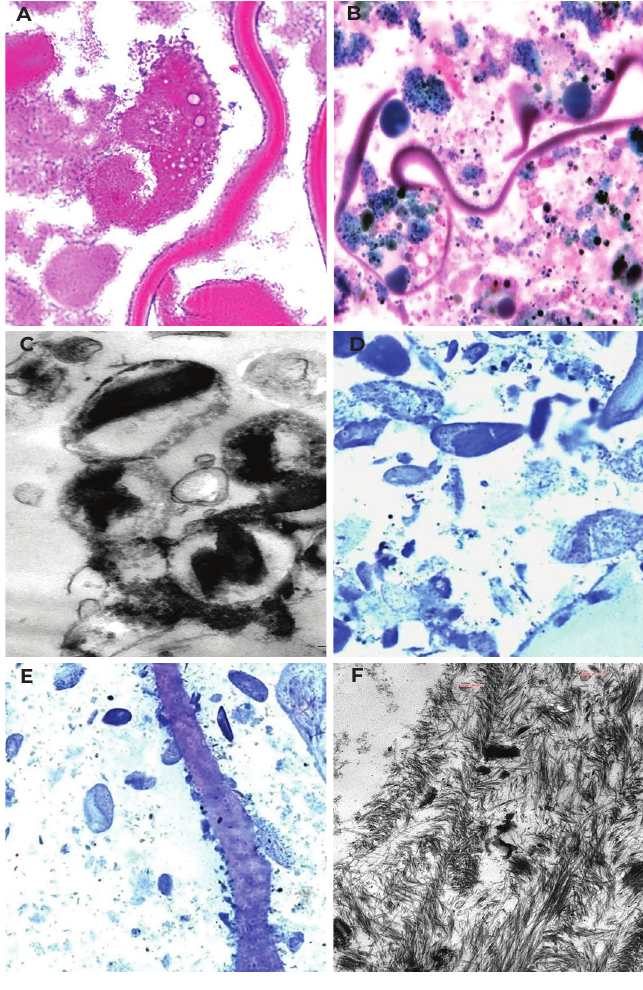
Figure 4 - Alveococcus of the liver 3 days after HIFU ablation. A - Destruction of protoscolex and laminae of alveococcal vesicles. Histological section x 400. B - Destruction of alveococcal larvocysts. Semi-thin slice x 1000. C - fragments of the destroyed calcium-containing cell. Electronogram x 34,000. D - numerous feather-like microcapsules. Semi-thin slice x 1000. E - microcapsules attached to and detached from the chitin sheath of alveococcus. Semi-thin slice x 1000. F - Destruction of the cell membrane of the microcapsule. Electronogram x